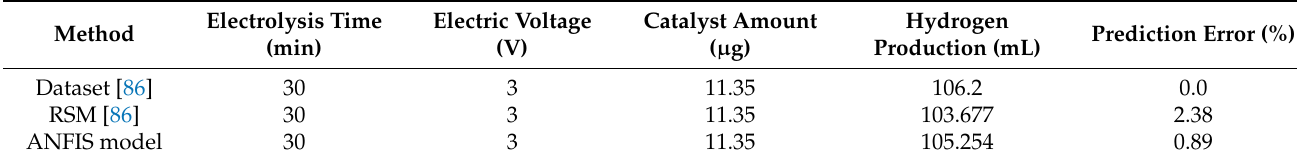
Table 2. Validation results.